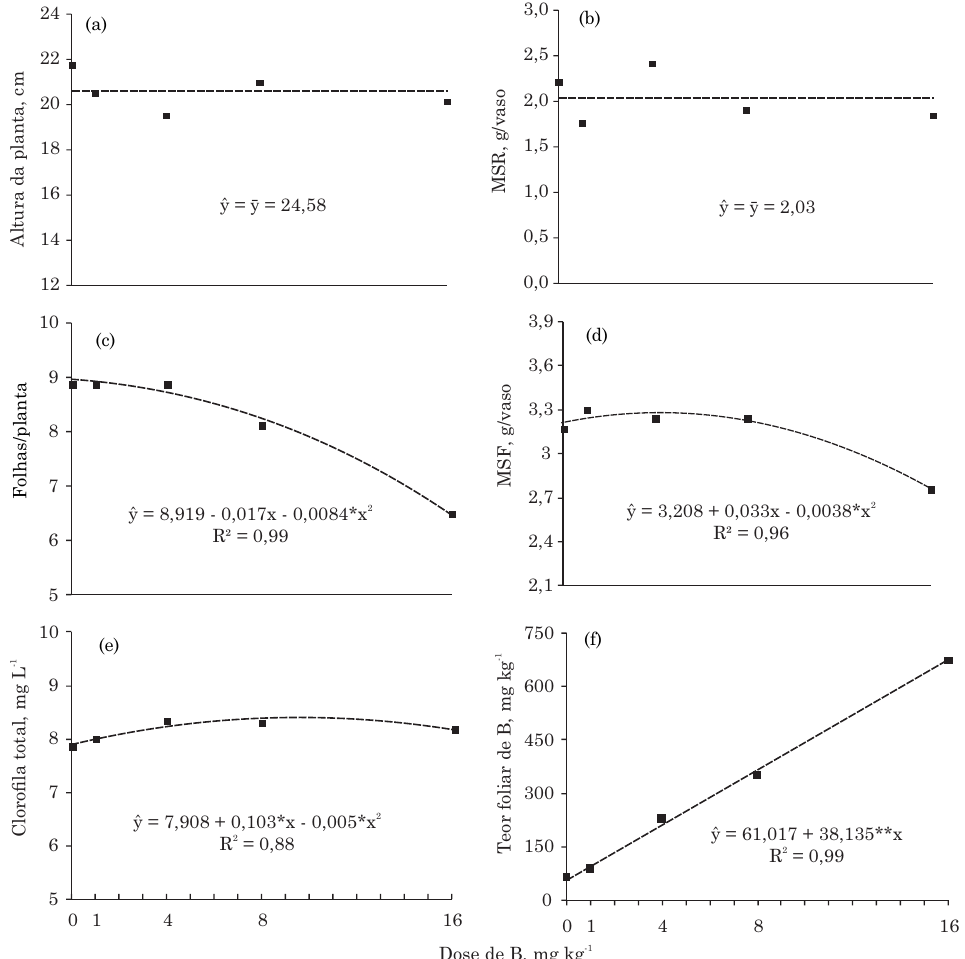
Figura 1. Altura da planta (a), produção de matéria seca de raízes (b), número de folhas por haste floral (c), produção de matéria seca de folhas (d), teor de clorofila total (e) e teor foliar de B (f) de roseira (cv. Shiny Terrazza ® ), em função da aplicação de doses de B no substrato. ** e *: significativo a 1 e a 5 %, respectivamente, pelo teste